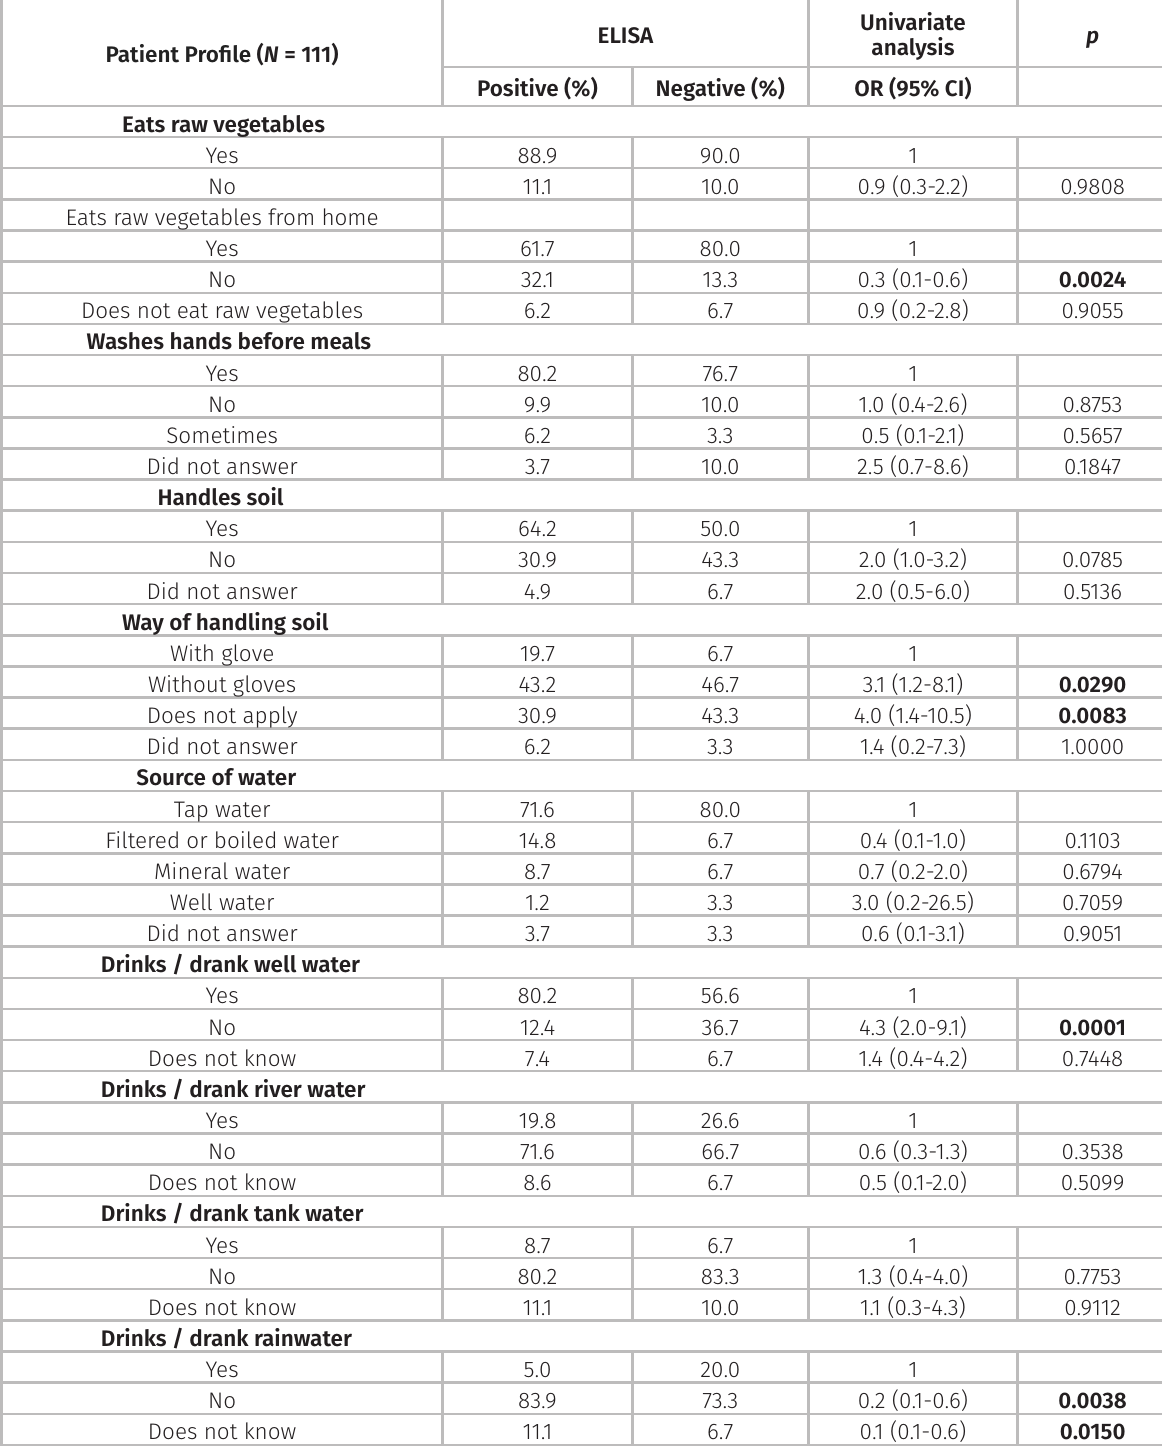
Table II. Univariate analysis of behaviors associated with oocyst ingestion in patients who were attended by the Expert Assistance Service of Foz do Iguaçu city, Paraná state, Brazil, in